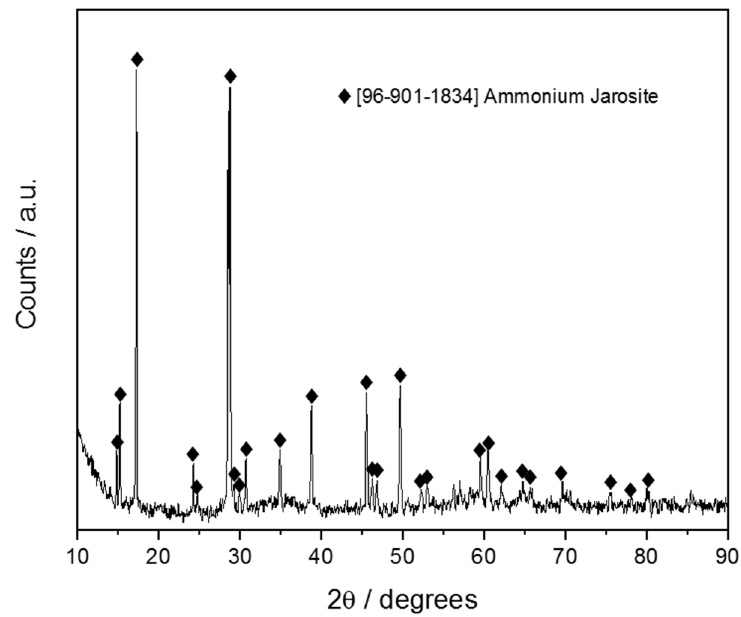
Figure 2. X-ray diffractogram of ammonium-sodium jarosite with arsenic.